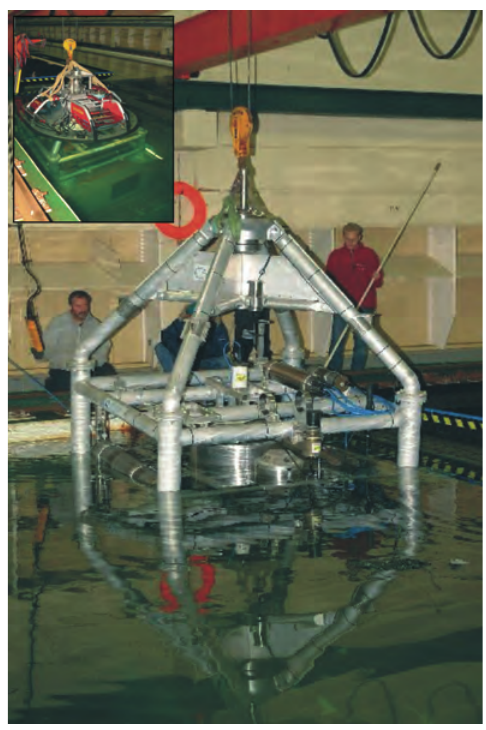
Fig. 8. MABEL during the low temperature tests at HSVA Basin in